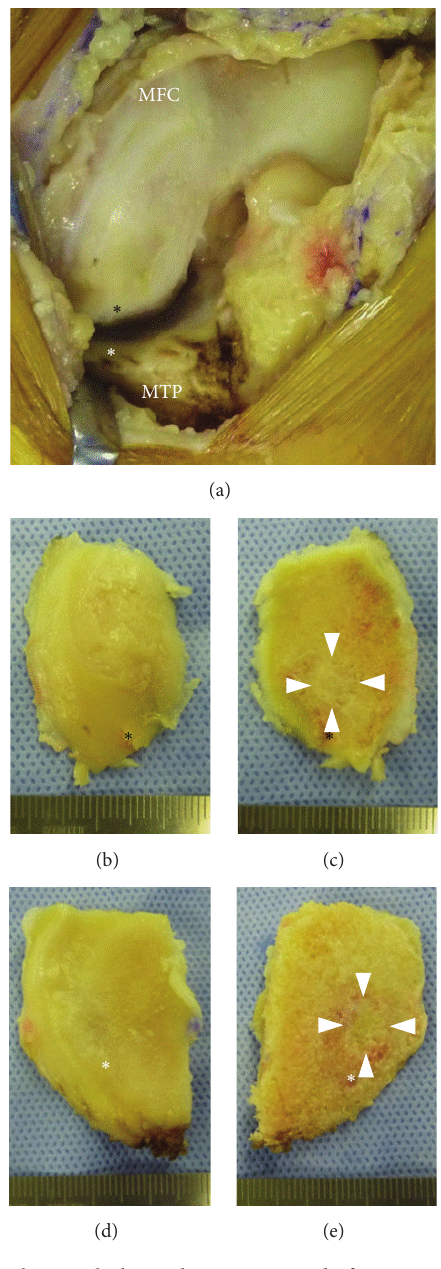
Figure 4: Intraoperative findings. (a) The black asterisk shows the posterior end of SPONK in the MFC, and the white asterisk shows the anterior end of SPONK in the MTP. (b, d) Articular and (c, e) back sides of the (b, d) MFC and (d, e) MTP specimens obtained during UKA. Focal lesions were clearly present in (c) and (e)